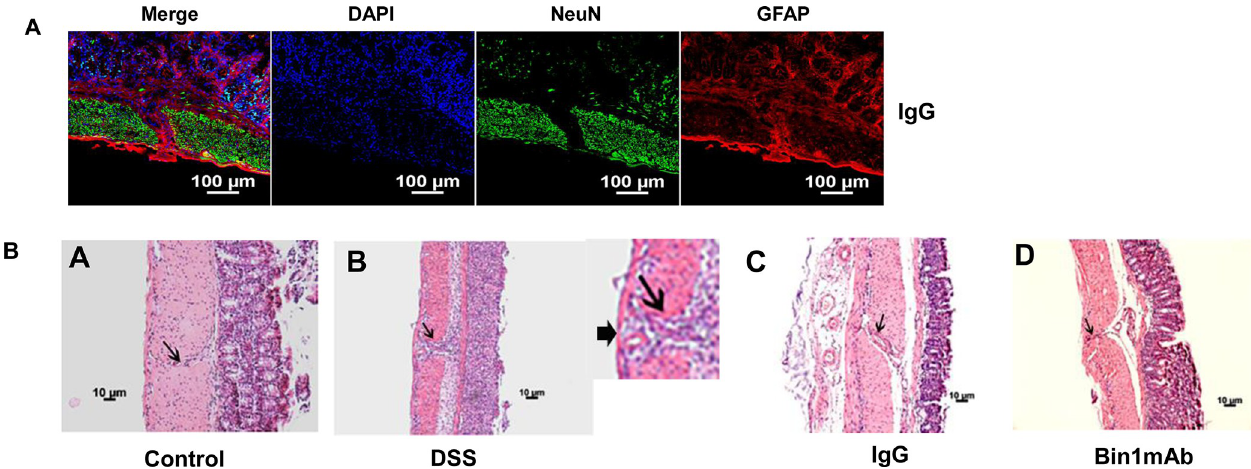
Fig 3. The muscularis of the colon is not a continuous entity. Fig 3A. The muscularis of the colon has openings ( anigma ) that transport glial cells (stained with GFAP), which protect the enteric neurons (n = 5). Fig 3B. H and E staining of the mouse colon showing that muscularis is not a continuous entity. The muscularis of the colon is punctuated with openings ( anigma ) (n = 5; representative image). Inset in figure B shows an intact serosa in the muscularis (large arrow) and anigma in the muscularis (long